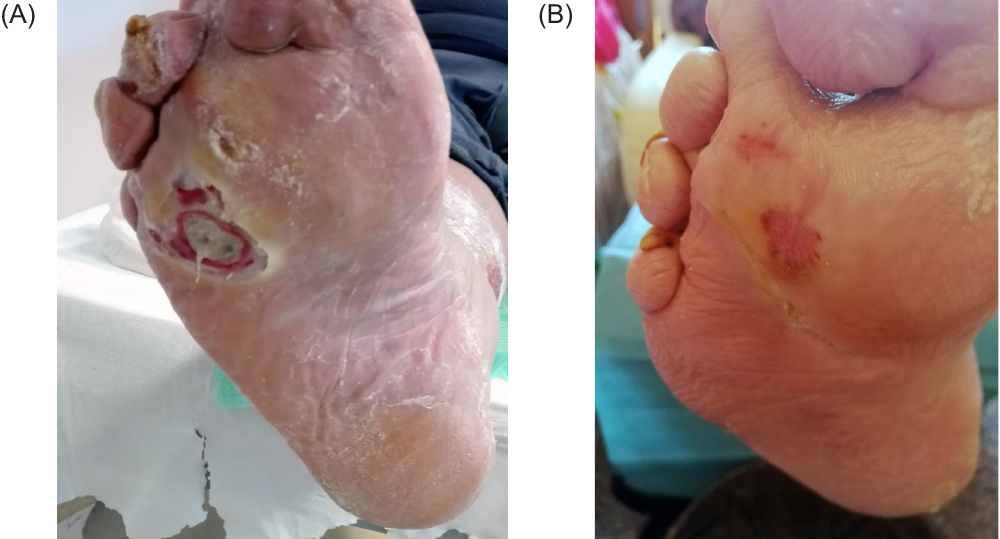
Figure 1. Foot ulcer before (A) and after (B) the intervention of multidisciplinary